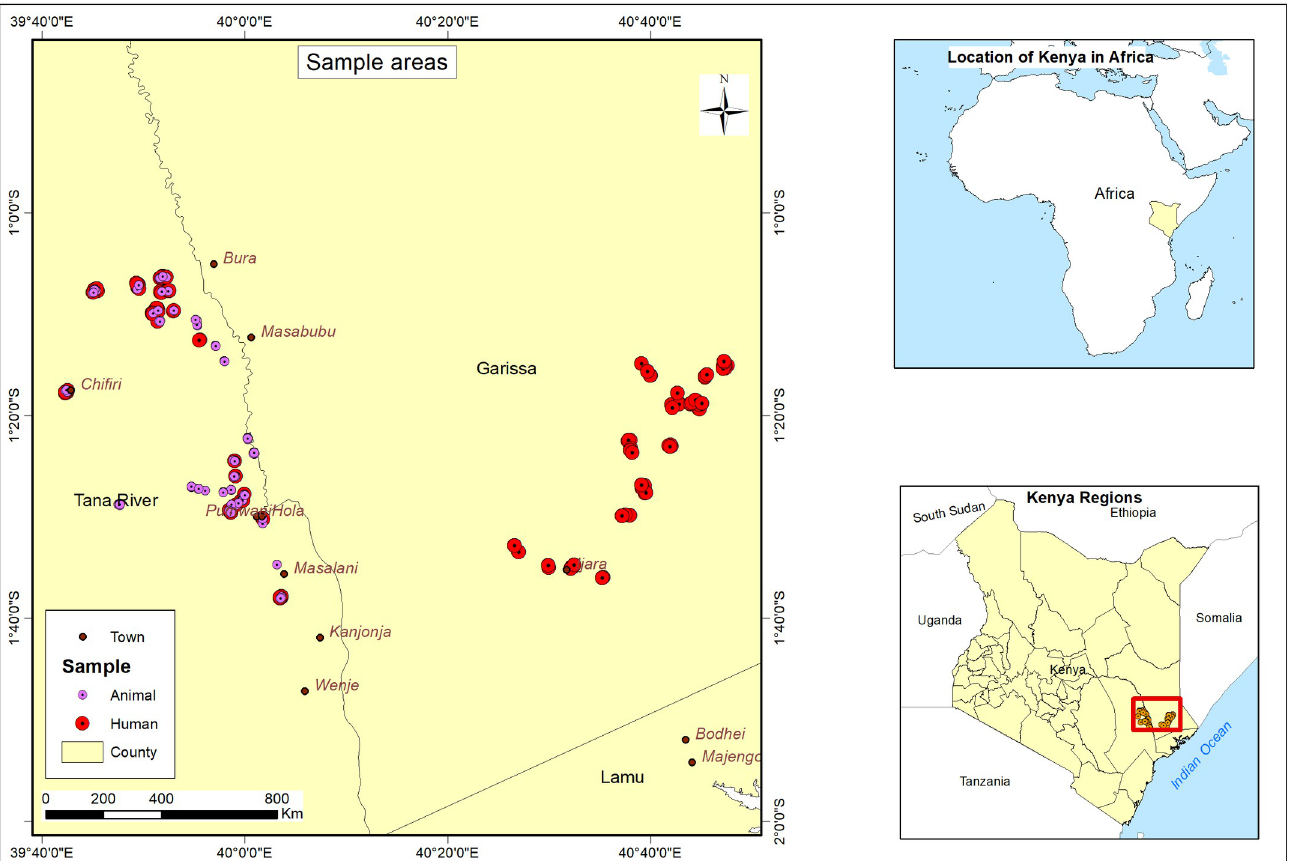
Fig 1. Map showing sampling sites. The base layer of the map used to create this figure was downloaded from https://www.diva-gis.org/gdata.